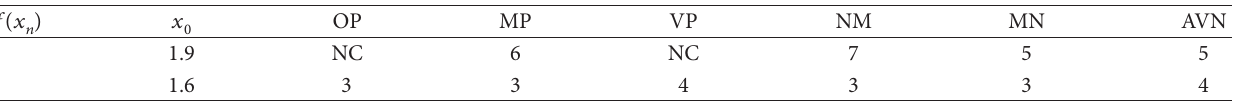
Table 4: The number of function evaluations required such that |1−𝑓(𝑥 𝑛 )/𝑓(𝑥 𝑒 )| < 10 −15 . NC states that the given method does not converge for the given root of (41) 𝑥 𝑒 = 2.1954